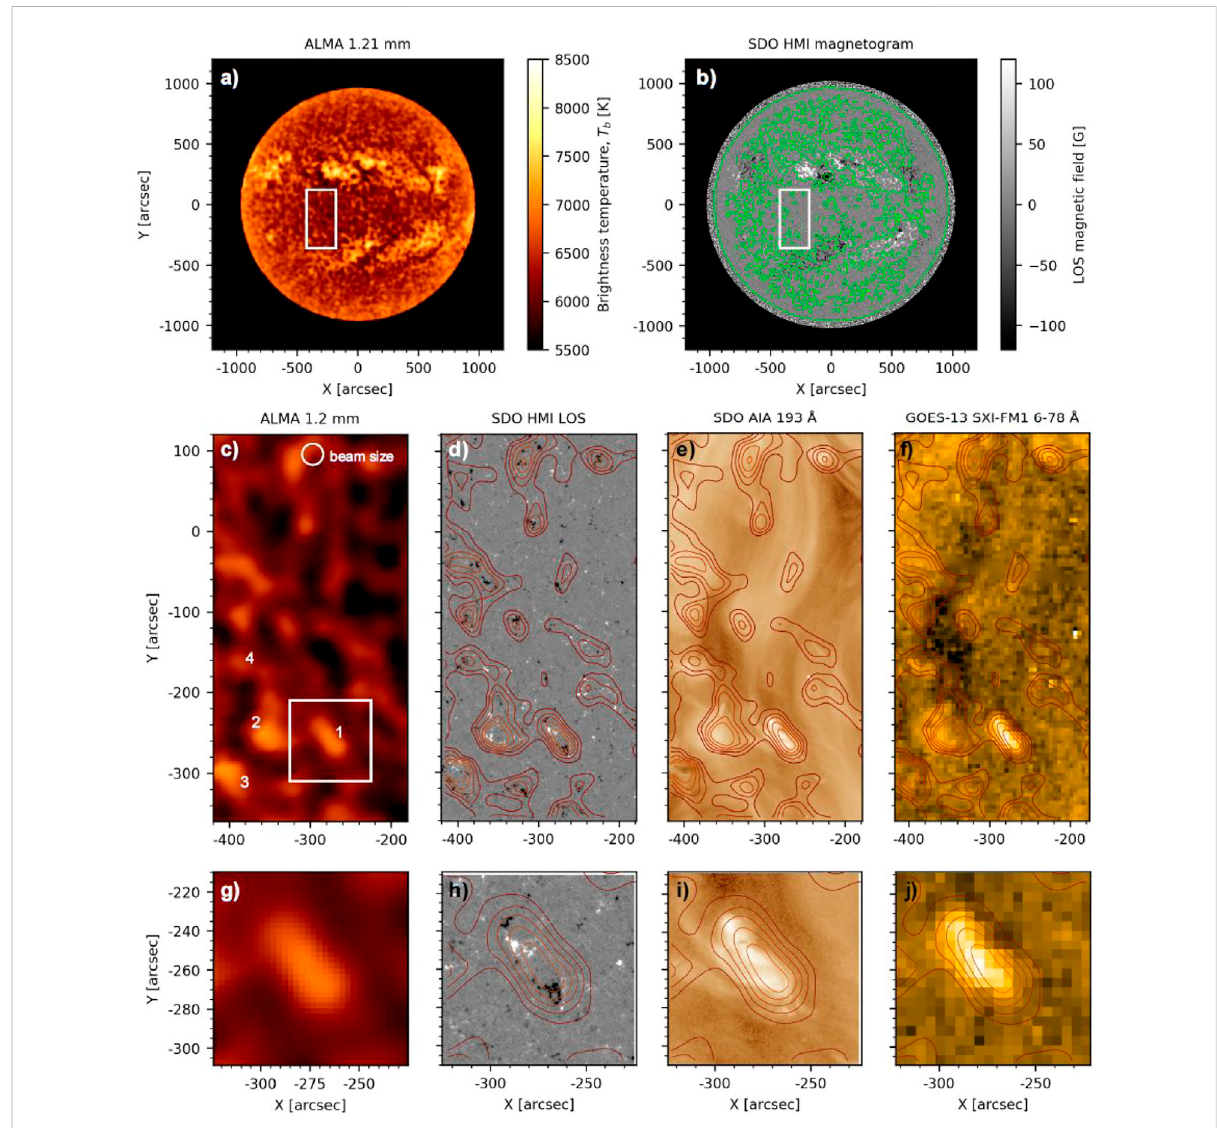
FIGURE 7 Differentviewsofcoronalbrightpoints:1.21 mm(ALMA),magnetic fi eld,EUV,softX-rays. (a) :Single-dishALMA248 GHz(1.21mm,Band6), (b) : SDO/HMI magnetogram, with white box outlining the quiet Sun area shown in panels in the middle row. Both images were taken on 18 December 2015 at 20:12 UT. Magnetogram intensity was clipped at ±120 G and ALMA contours of 6500 K were overlaid in green color. (c) : the ALMA image of thequietSunshownenlargedandcomparedwith (d) :SDO/HMImagnetogram, (e) :SDO/AIA193 Å fi ltergram, and (f) :GOES-13SXItin(Sn) fi lter image, with ALMA contours overlaid (levels at 6300, 6400, 6500, 6600 and 6700 K) (g – j) : enlargements of a single ALMA bright feature, marked in thewhite rectangle inpanel (c) ,atthesamewavelengths asinthemiddle row.Thebeamsize ofthesingle-dishALMA measurements, 26 ″ ,isgivenin the panel (c) . Reproduced from Braj š a et al. (2021) with permission ⓒ